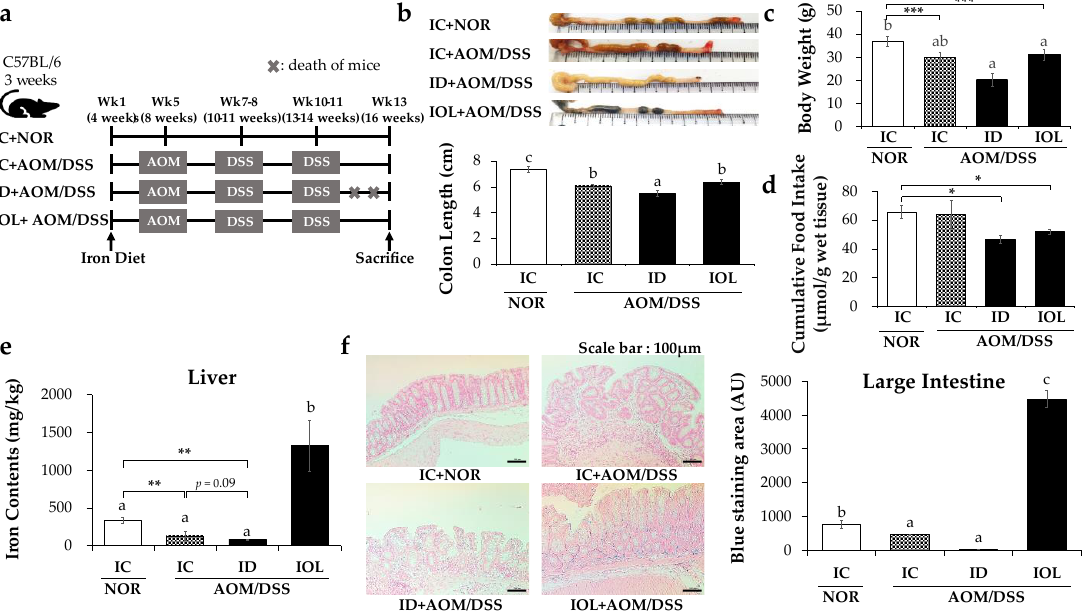
Figure 1. Amount of dietary iron changes inflammation and iron status in the large intestine. Exper- imental timeline ( a ), and colon length data ( b ) and body weight at final week ( c ), cumulative food intake ( d ) of each group (IC + NOR, IC + AOM/DSS, ID + AOM/DSS, IOL + AOM/DSS). ICP-OES & ICP-MS data measuring the amount of iron in the liver ( e ) and Perls’ Prussian blue staining of the large intestine of mice and the intensity of staining visible within a tissue section ( f ) are presented. Data are expressed as Mean ± SD. One-way ANOVA was used for the test of difference and Tukey for the post- hoc test. Different letters above the value indicate statistical significance. Student’s t - test was used to test the difference between two groups, and the asterisk represents statistical sig- nificance (* p < 0.05; ** p < 0.01, *** p < 0.001). Scale bar = 100 μm. Abbreviations: NOR, normal; AOM/DSS, azoxymethane/dextran sodium sulfate; IC, iron control; ID, iron-deficient; IOL, iron overload; AU, arbitrary units.